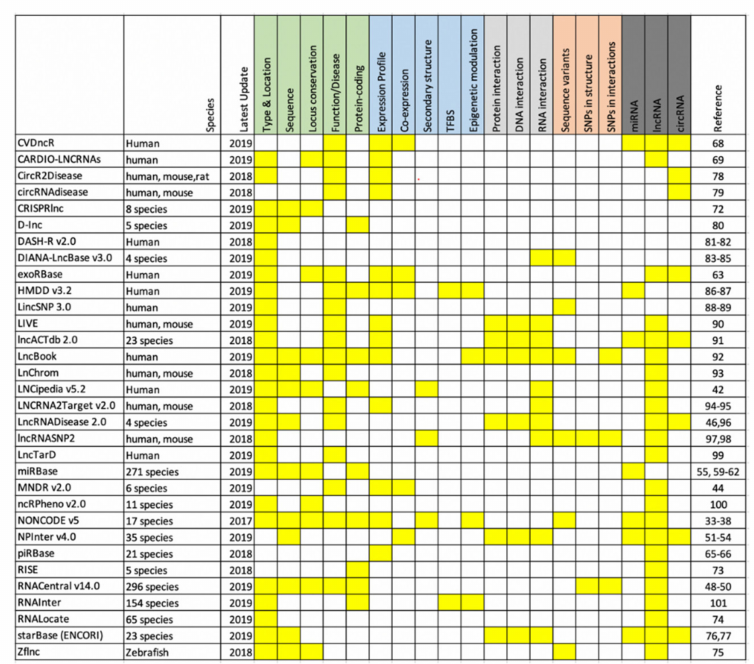
Figure 2. Overview of current ncRNA databases: The available databases have been grouped into five categories: basic genomic annotation (green), expression profile (blue), molecular interactions (light grey), Disease association (orange) and ncRNA type (dark grey). The corresponding boxes are shaded in yellow if the details are present in the respective databases